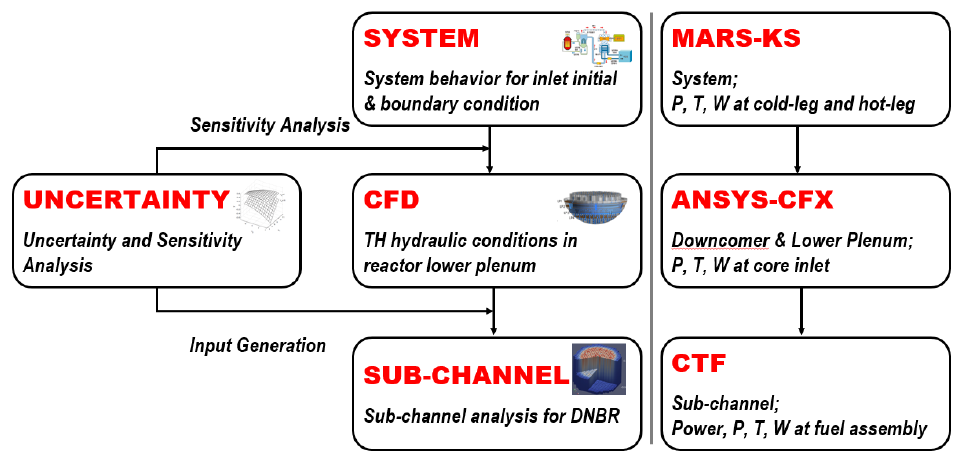
Figure 2. Code system and flow of information for DNBR.